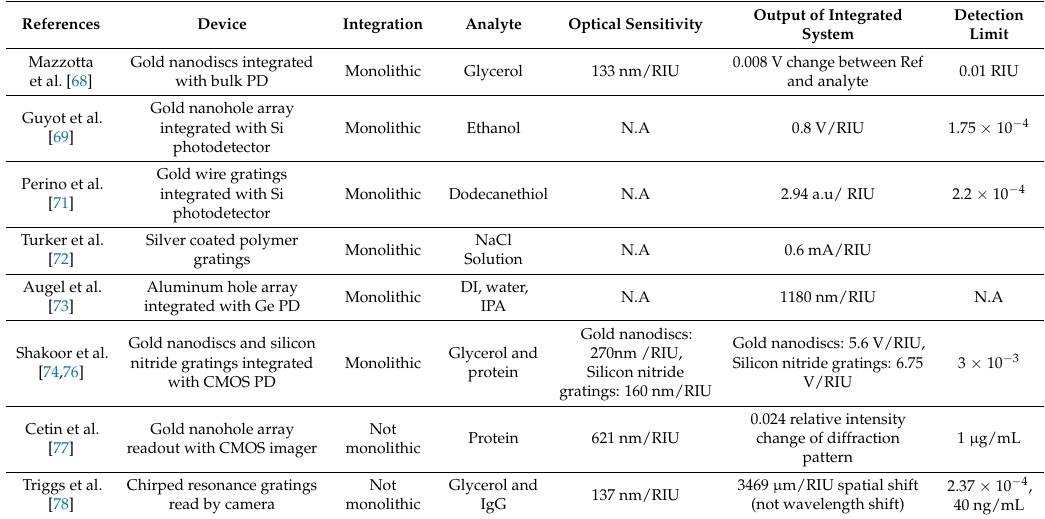
Table 1. Summary of onchip nanophotonic sensors having compact readout